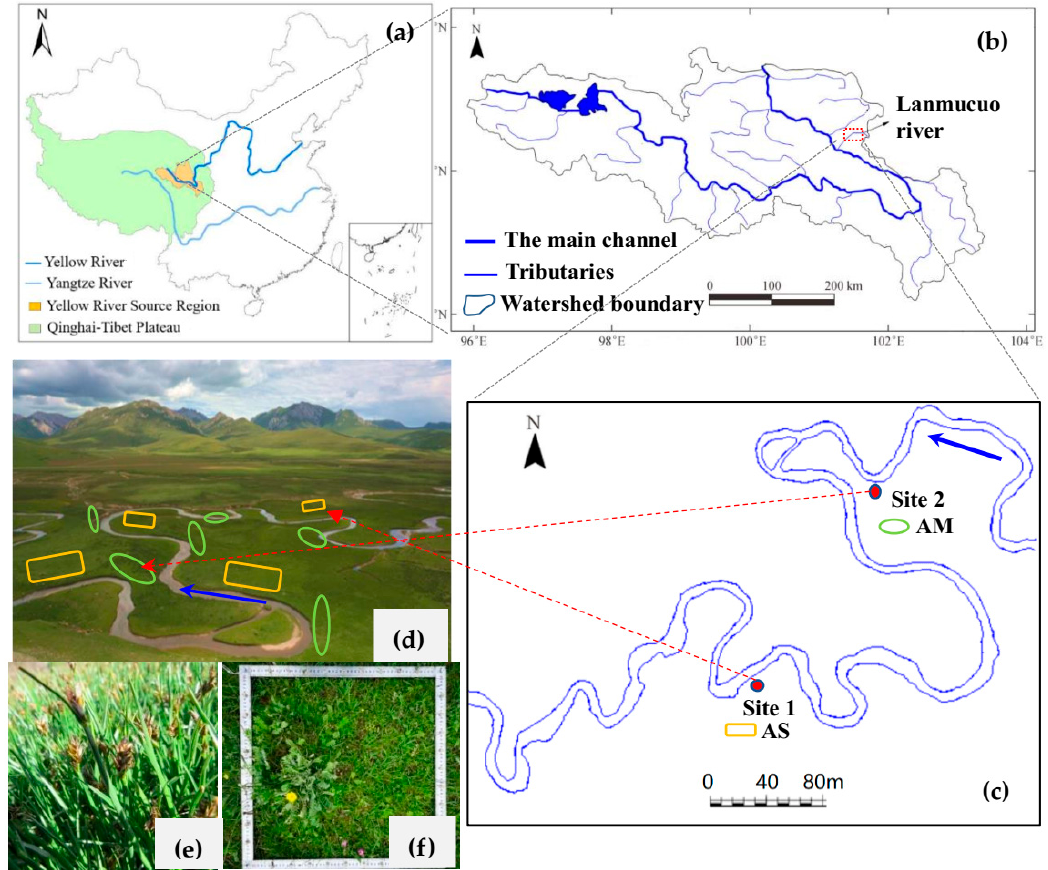
Figure 1. ( a ) The geography of the Qinghai-Tibet Plateau and Upper Yellow River; ( b ) the location of the study area in the Lanmucuo river; ( c ) the specific locations of the two selected sites; ( d ) the spatially distributed AS and AM along the riparian zone of the Lanmucuo River; ( e ) illustration of Blysmus sinocompressus , the dominant species of AS; ( f ) demonstration of the AM that is rich in species composition (some degraded species are discernable).